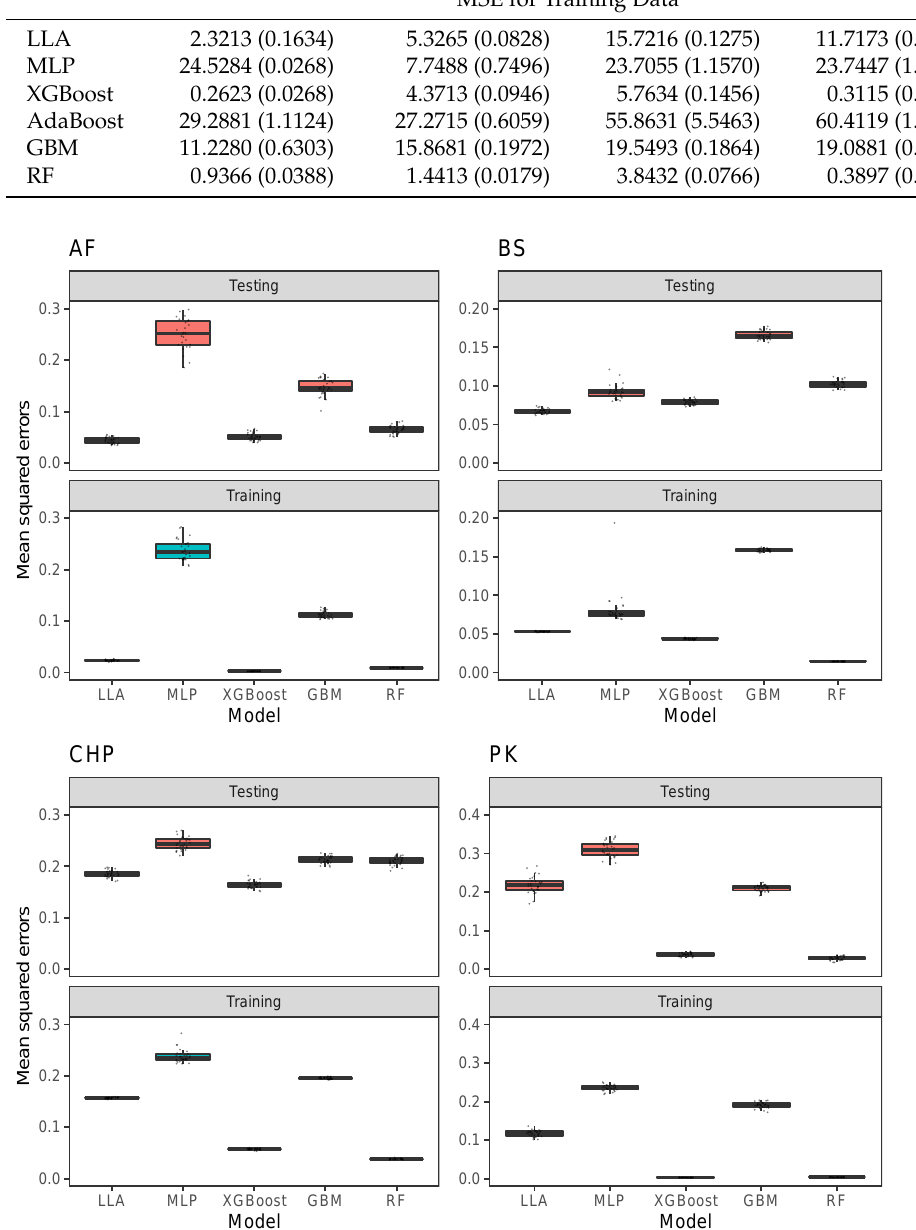
Figure 4. Comparison with commonly-used procedures with default hyper-parameter value for regression